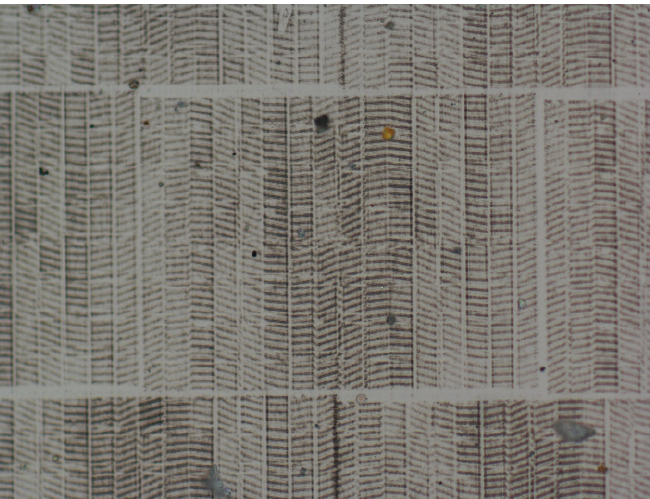
Figure 8. A photograph of a region of the photoresist with the structure of interference fridges formed using the views of the holographic object, as compiled in Figure 5b.